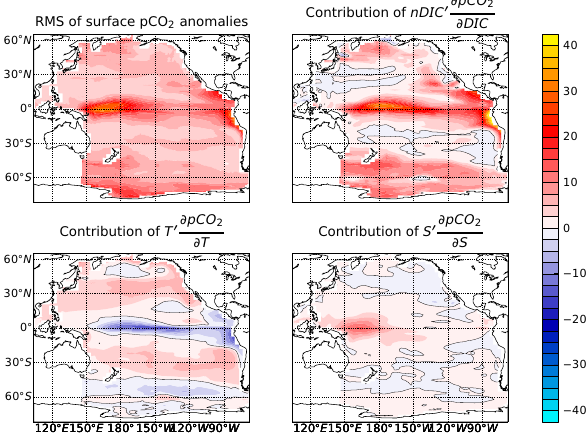
Fig. 4. Partitioning of the mechanisms driving interannual vari- ability in the air–sea p CO 2 difference, 1p CO 2 (µatm), in the CCSM BEC ocean model. ppmv is numerically equal to 1p CO 2 (µatm) when the barometric pressure is assumed to be 1.0 atmo- sphere. The panels show the root mean square of the model desea- sonalized surface-water 1p CO 2 anomalies (1990–2009) (top left) and the contributions from surface-water salinity-normalized dis- solved inorganic carbon (top right), temperature (lower left), and fresh water/salinity (lower right). The contributions from salinity- normalized alkalinity (not shown) are generally